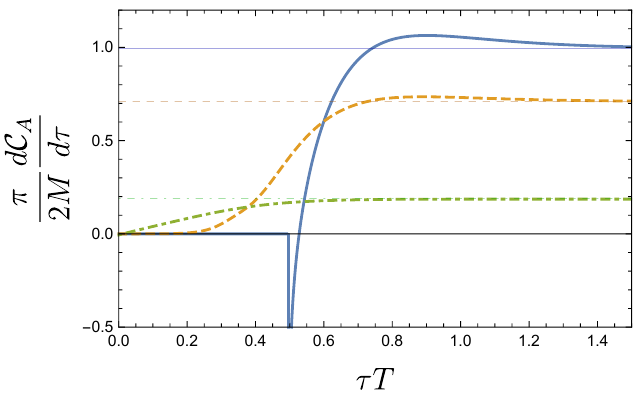
Figure 11 . The time derivative of complexity with d = 4, k = 0 and non-zero chemical potential, obtained by (cid:12)xing the parameters in eq. (4.29). The various curves correspond to: (cid:23) = 0 : 1 in blue (solid) , (cid:23) = 1 in orange (dashed) and (cid:23) = 5 in green (dot-dashed). We varied the chemical potential while (cid:12)xing the temperature as TR = 1 , where as before the scale R in the planar geometry is 2 related to an arbitrary scale in the boundary